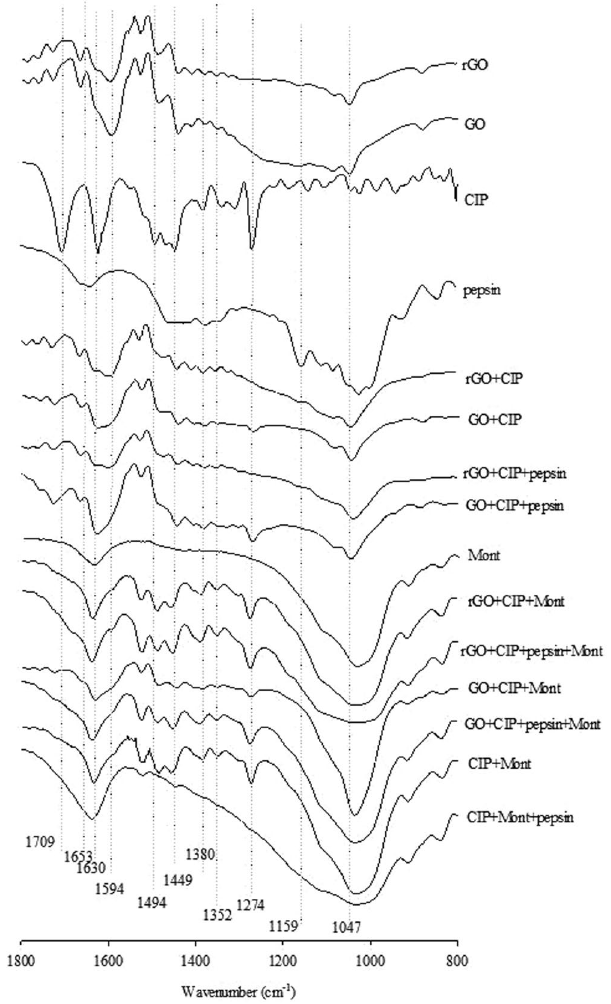
Figure 5. FTIR spectra of GO, rGO and Mont under the varying interaction systems after adsorption at the range of 800 to1800 cm − 1 at pH